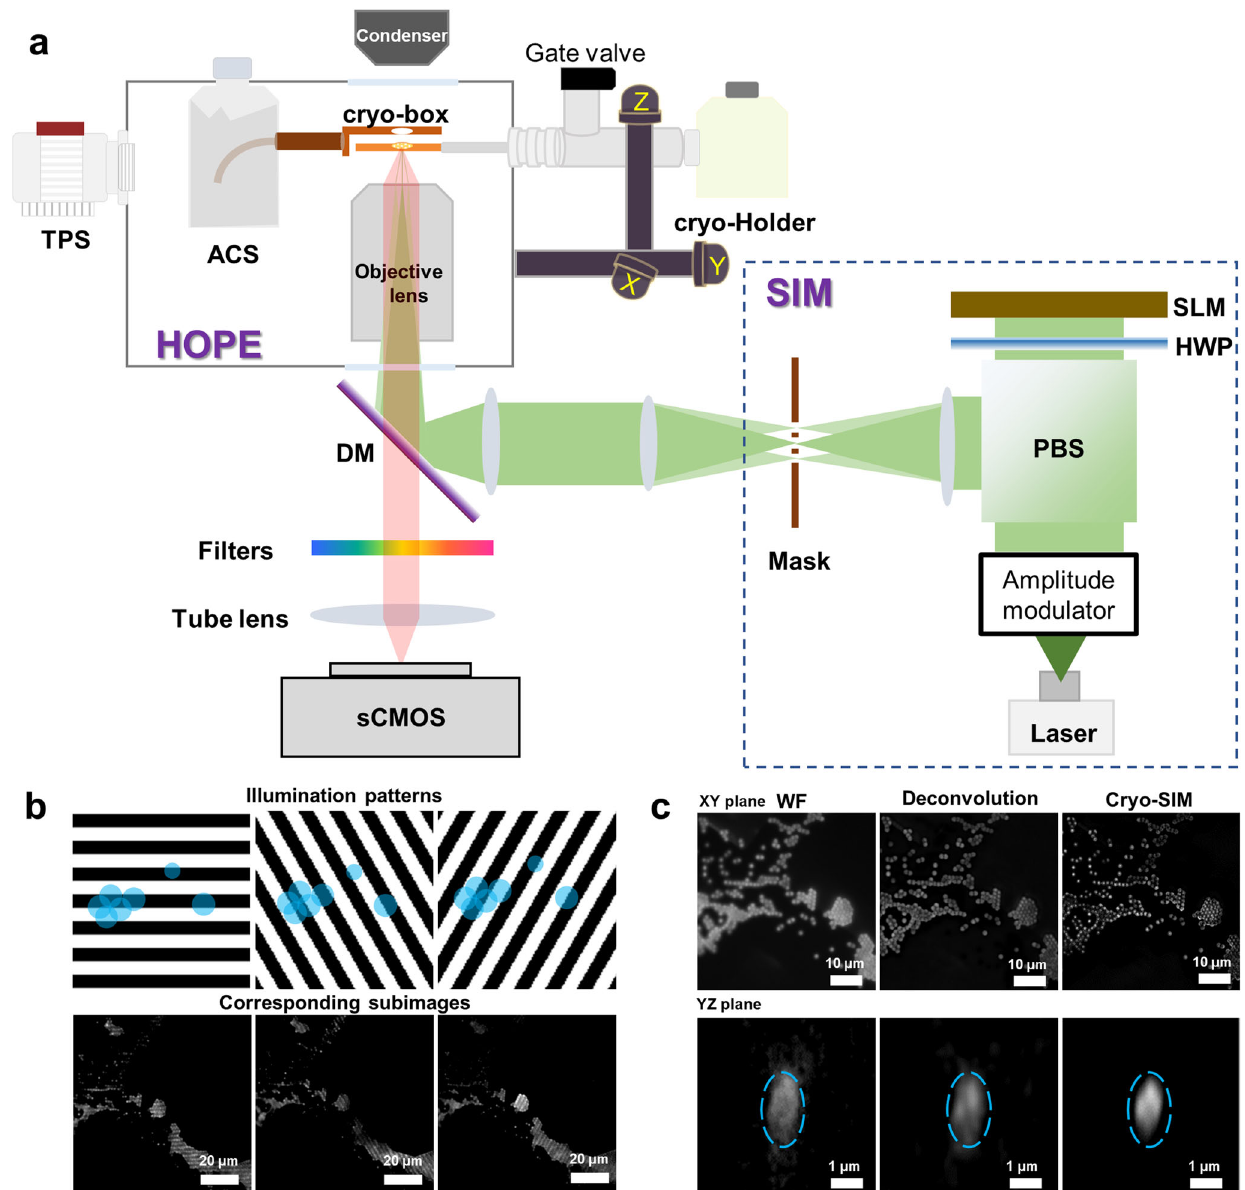
Fig. 2 Design and principle of the HOPE-SIM system. a Schematic overview of the HOPE-SIM system design in its operational mode. Each part of the system is labeled and described in the text. A structured illumination beam is induced into the microscope via the backlight inlet. TPS turbo pump system, ACS anti-contamination system, DM dichroic mirror, SIM structured illumination microscopy, SLM spatial light modulator, HWP half-wave plate, PBS polarizing beam splitter. b Diagrammatic (top) and real (bottom) corresponding subimages of the cryo-SIM illumination patterns (black and white) on the fl uorescence microspheres (blue). c Comparisons of fl uorescent images of 1- μ m microspheres among different imaging modes: wide- fi eld